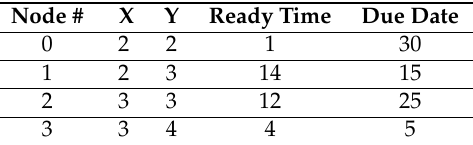
Table 2. The input data for the network G 1 .